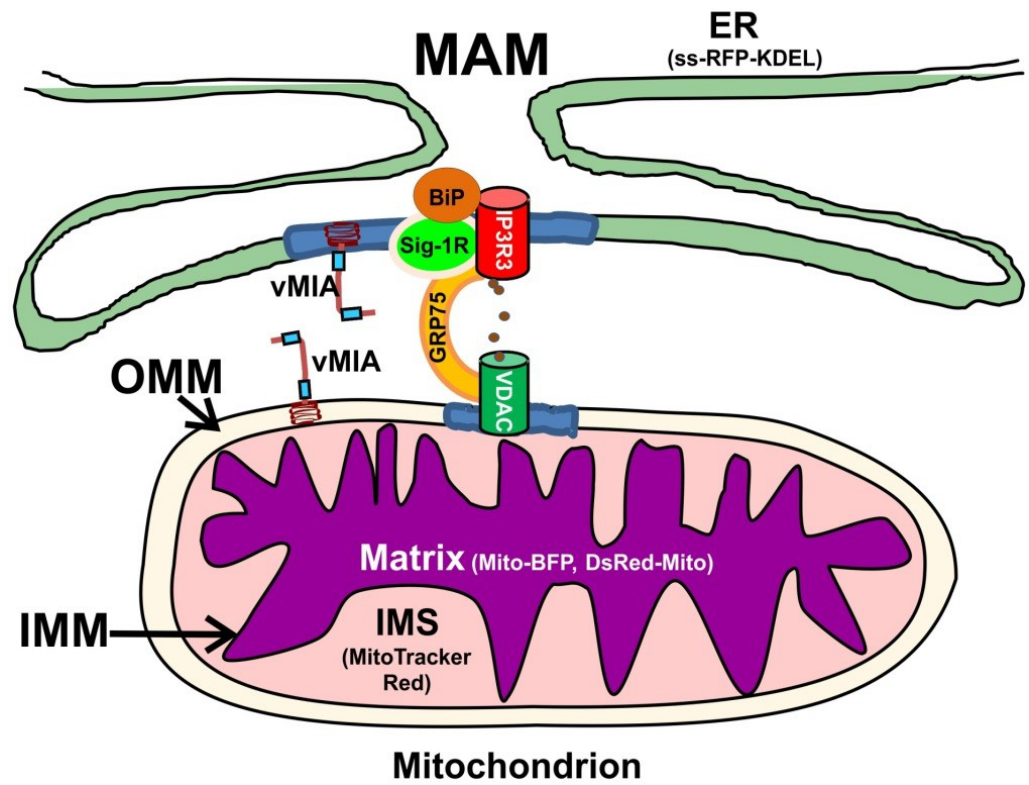
Figure 1. Endoplasmic reticulum (ER), mitochondria-associated membranes (MAM), and mitochondrial sub-compartments visualized. Viral mitochondria-localized inhibitor of apoptosis (vMIA) localization in the MAM and mitochondrion sub-compartments was imaged using the following markers: preprolactin signal sequence (ss) fused to the N-terminus of the red fluorescent protein (RFP) with a KDEL ER retention signal at its C-terminus (ss-RFP-KDEL, for ER) [36] and mitochondrial Cox 4 leader fused to Tag blue fluorescent protein (Mito-BFP)/mitochondrial targeting sequence from human cytochrome c oxidase subunit VIII to the N-terminus of Discosoma RFP (DsRed-Mito, for mitochondrial matrix) [37]. We use MitoTracker Red as an intermembrane space (IMS) marker based upon the superresolution imaging of MitoTracker by others [38,39] and our own results herein. Contacts between the ER and mitochondria are shown, with the MAM Ca 2+ signaling complex components on the ER (IP3R3), cytosol (GRP75) and outer mitochondrial membrane (OMM) (voltage dependent anion channel (VDAC)). MAM Ca 2+ efflux from the ER is regulated by chaperones (BiP, Sig-1R) as well as vMIA. Lipid rafts (blue) containing the Ca 2+ signaling complex and vMIA are shown. These components are shown in the